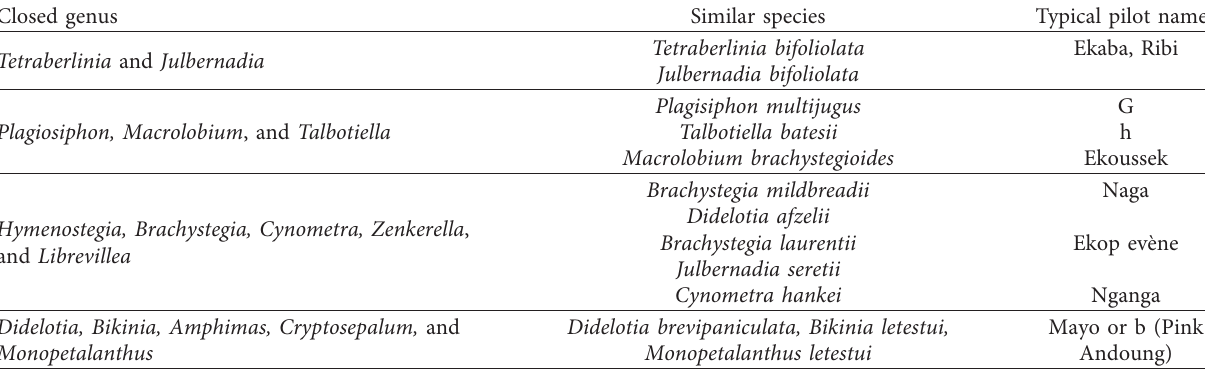
Table 2: Taxonomic grouping of Ekop for market